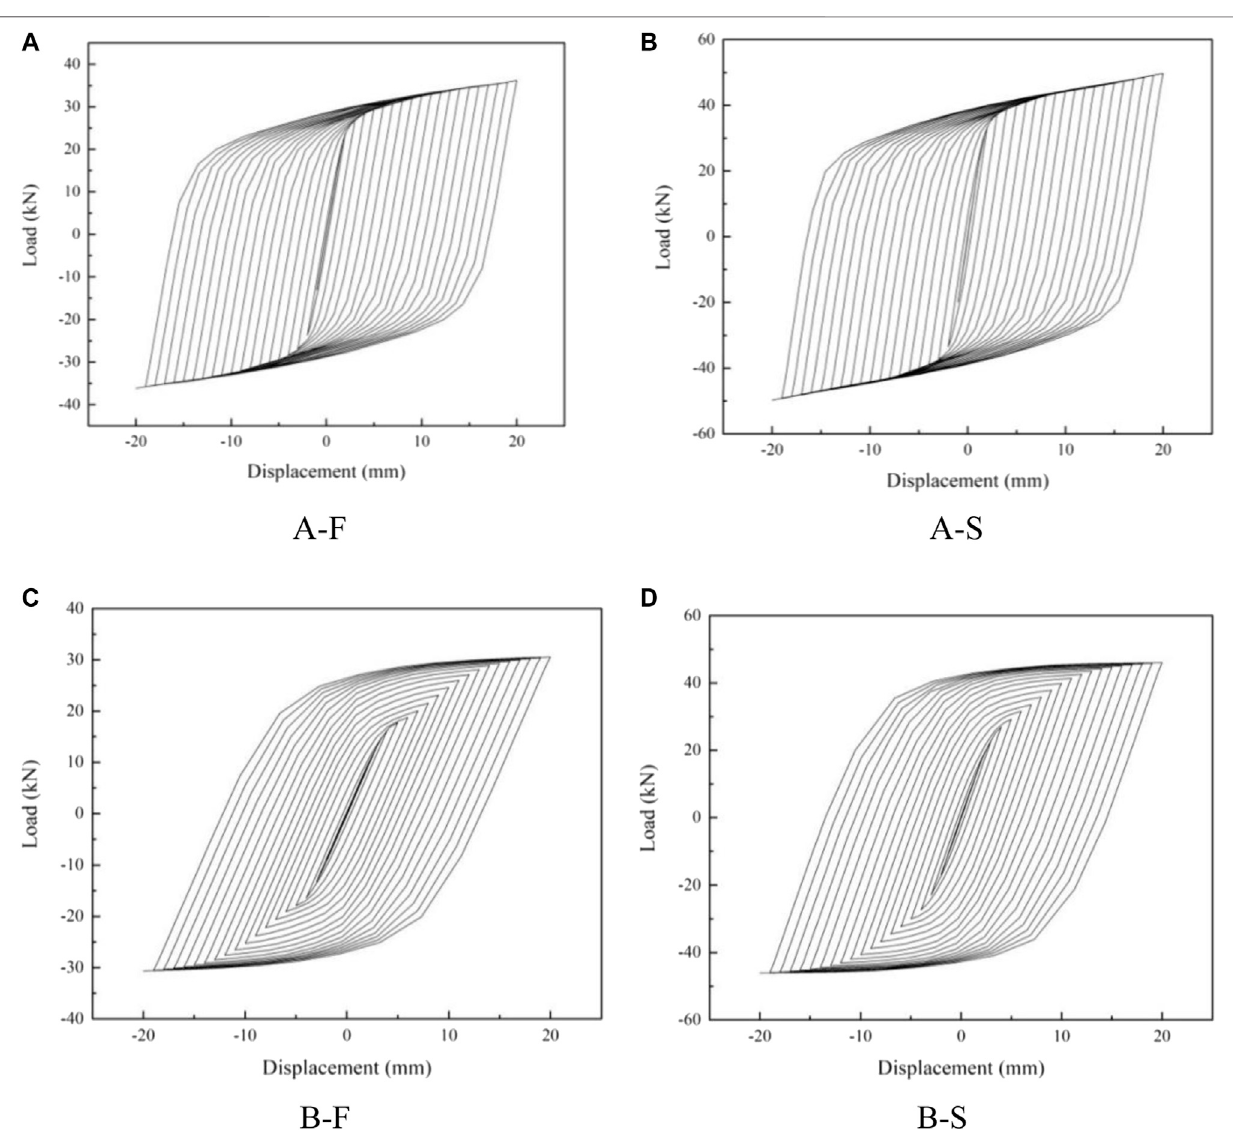
Frontiers in Materials |